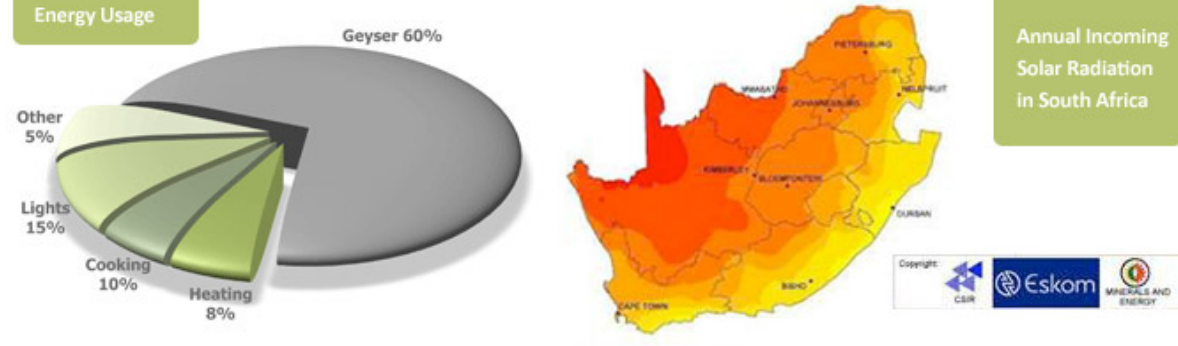
Fig. 5. Energy usage in a household